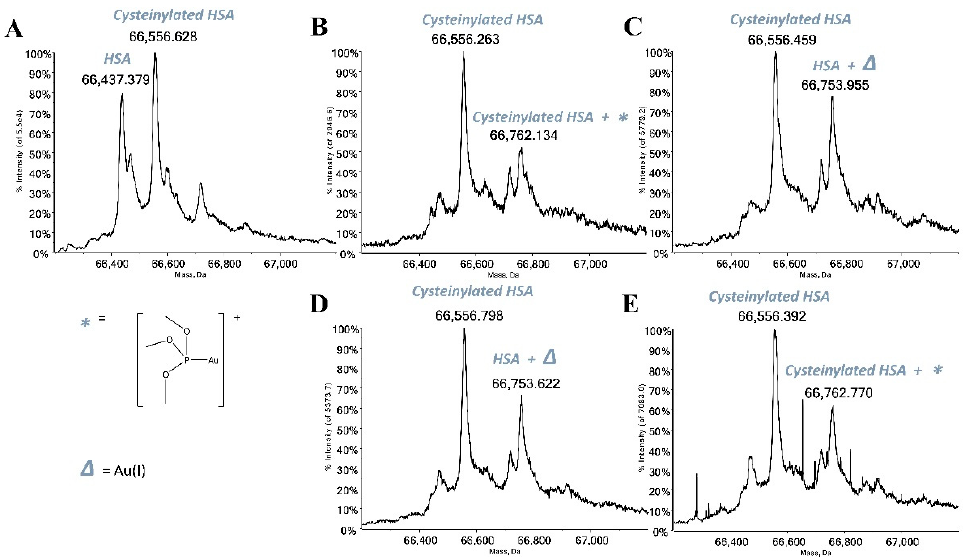
Figure 3. ( A ) Deconvoluted ESI-MS mass spectra of human serum albumin (HSA) 10 − 6 M in 20 mM ammonium acetate solution at pH 6.8, incubated at 37 °C for 5 min with ( B ) AuP(OCH 3 ) 3 Cl, ( C ) AuP(OCH 3 ) 3 Br, ( D ) AuP(OCH 3 ) 3 I, ( E ) AuP(OCH 3 ) 3 SAtg solution in a 1:3 protein-to-gold ratio; 0.1% v / v of formic acid was added just before injection.